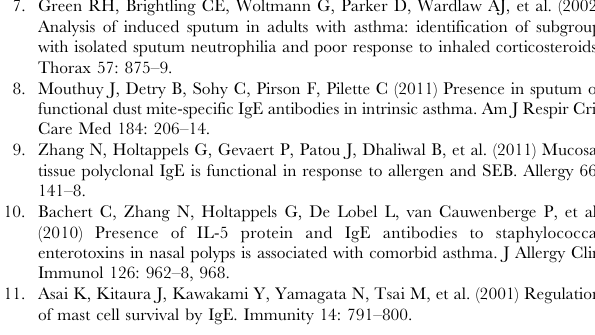
Healthy subjects